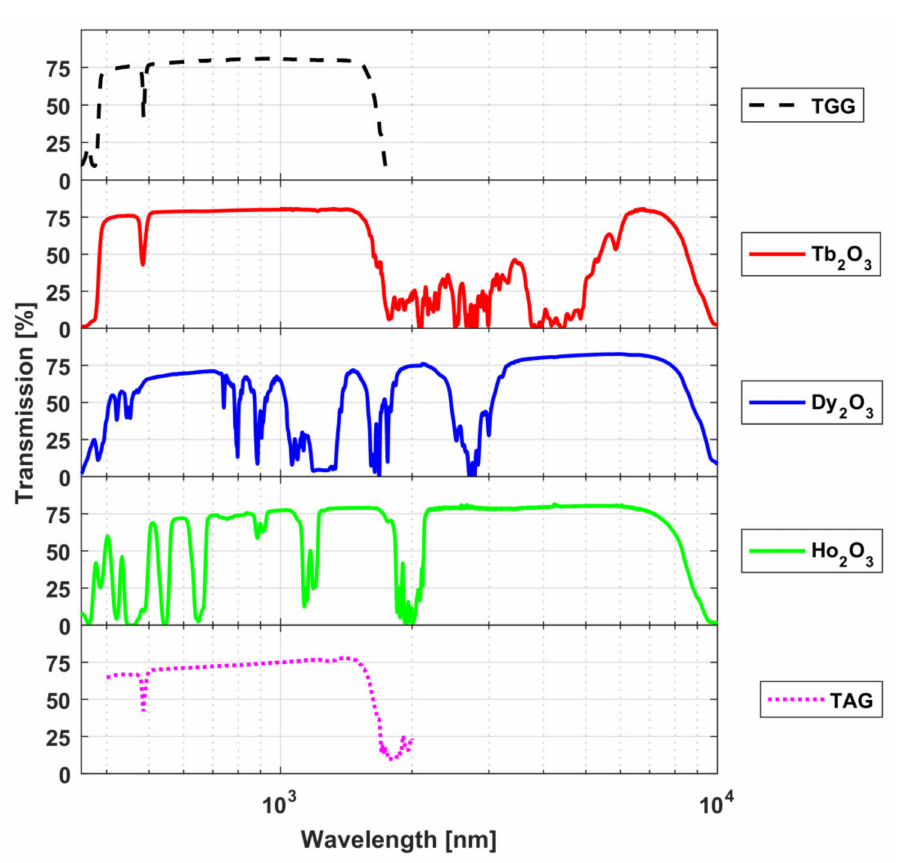
Figure 8. Recommended ranges of transmission spectra: TGG [39], Tb 2 O 3 [39,40], Dy 2 O 3 [42], Ho 2 O 3 [43,44],